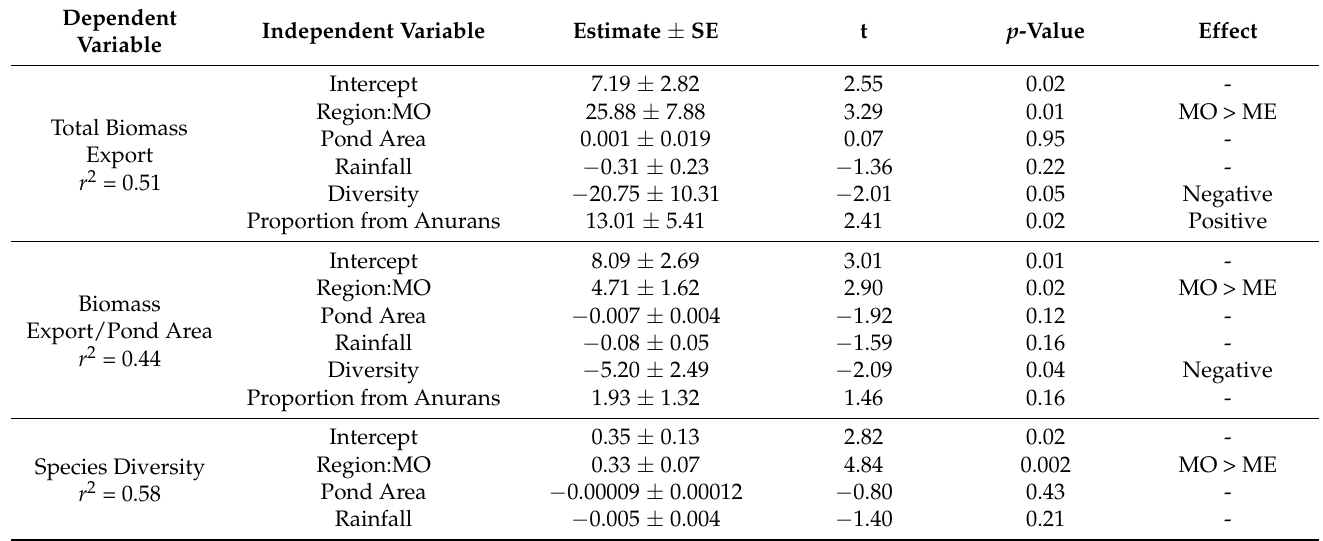
Table 3. Results from mixed models predicting the effects of different variables on amphibian biomass export from geographically isolated wetlands and the community composition of that export. All models had pond and year × region as random variables to account for the lack of independence of biomass estimates from the same pond and from the same year in the same region. Regions included Missouri (MO) and Maine (ME), USA. N = 46 for total biomass export and biomass export per wetland area. N = 45 for diversity and proportion of biomass from anurans, because one pond produced zero juveniles one year. r 2 = marginal r 2 for mixed effect